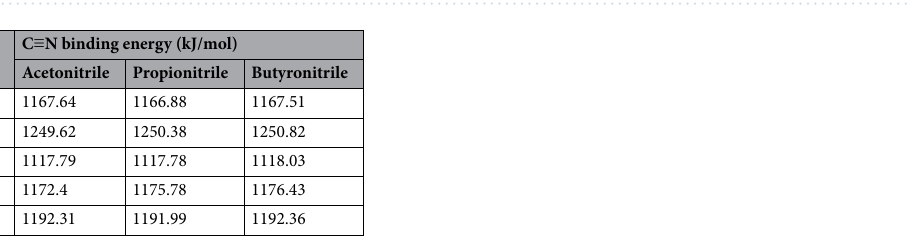
Table 2. Binding energies (C ≡ N bond) calculated for various organic nitrile solvents (kJ/mol). *C ≡ N binding energy (kJ/mol). *Basis set: 6-311++